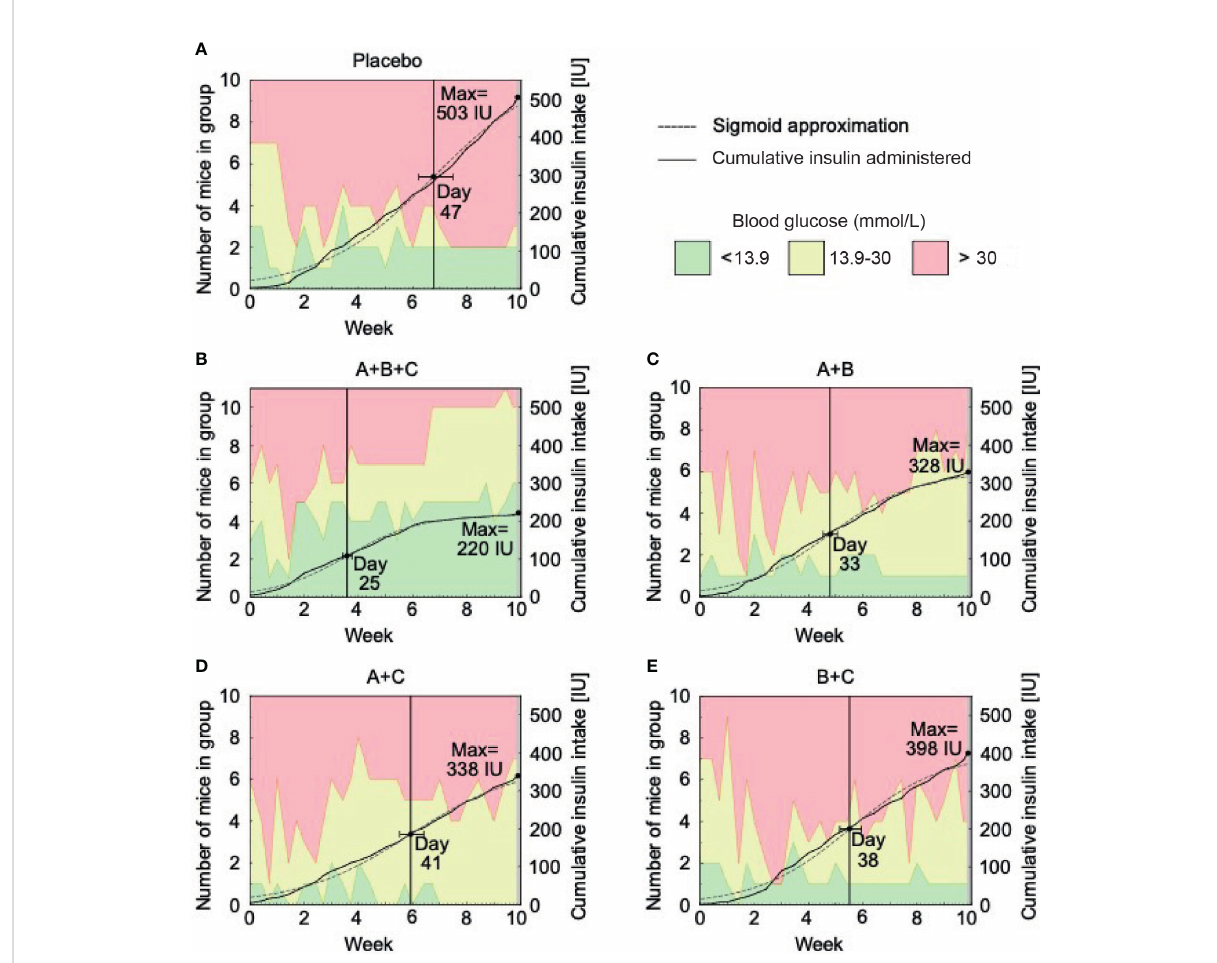
FIGURE 3 Insulin requirements decrease with triple therapy (A+B+C) in NOD mice. This arm of the experiment was performed on 51 mice with con fi rmed diabetes (blood glucose >13.9 mmol/L) at the start of drug therapy. The placebo (A) , A+B (C) , A+C (D) and B+C (E) groups included 10 mice each and the A+B+C (B) group included 11 mice. The graphs show the number of mice within the different glucose levels (green area represents normoglycemic mice with blood glucose levels below 13.9 mmol/l, yellow represents hyperglycemic mice without insulin therapy with blood glucose levels between 13.9 - 30.0 mmol/l and red represents severely hyperglycemic mice on insulin therapy with blood glucose levels above 30.0 mmol/l) and the cumulative amount of insulin administered to them during each week of the study. Additionally, a sigmoid approximation model of the exogenous insulin used in each group and the anticipated day of a reduced insulin administration intensity are